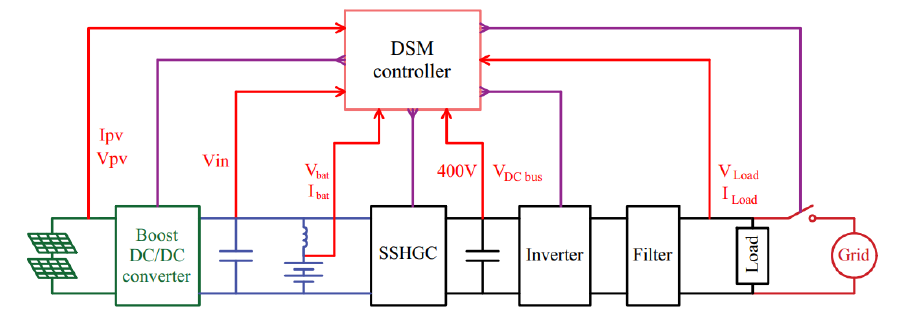
Figure 12. The system block diagram.